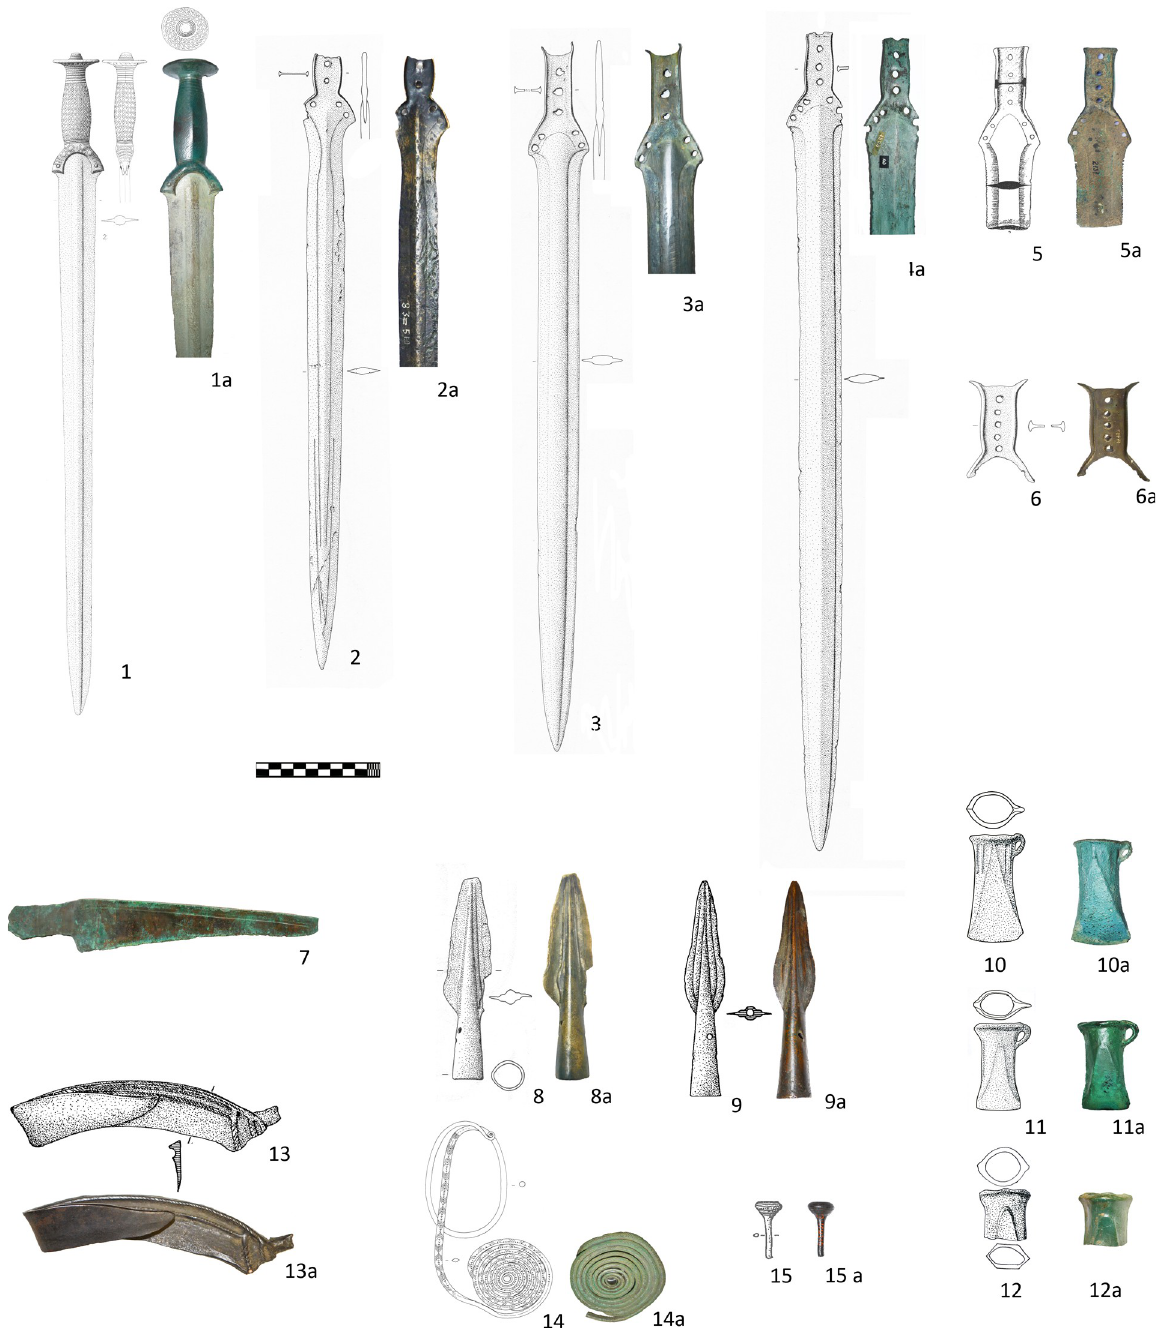
Fig 2. Group 1 of sampled metal objects (BA D–Ha A1). 1. 4. 10. 14: Topolnica; 2: Radaljska Ada; 3: Antoni ć i; 5: Kli č evac-Rastova č a; 6: Trli ć ; 7: Mali Dol; 8: Novigrad; 9. 13. 15: Futog; 11. Urovica: 11; 21. Privina Glava (1–4. 6: reprinted from [41] under CC BY license with permission